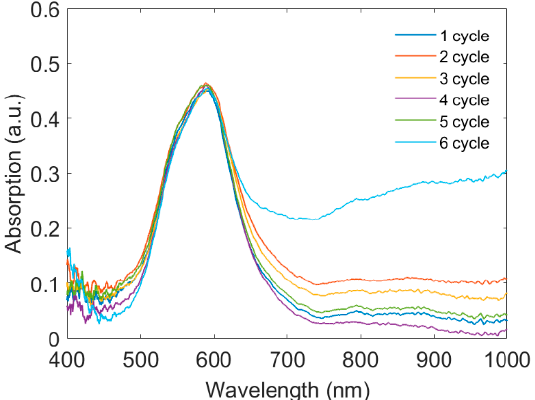
Figure 9. Absorption spectra of the LSPR sensor when an EDTA solution is used for releasing Ni 2+ ions for six cycles.